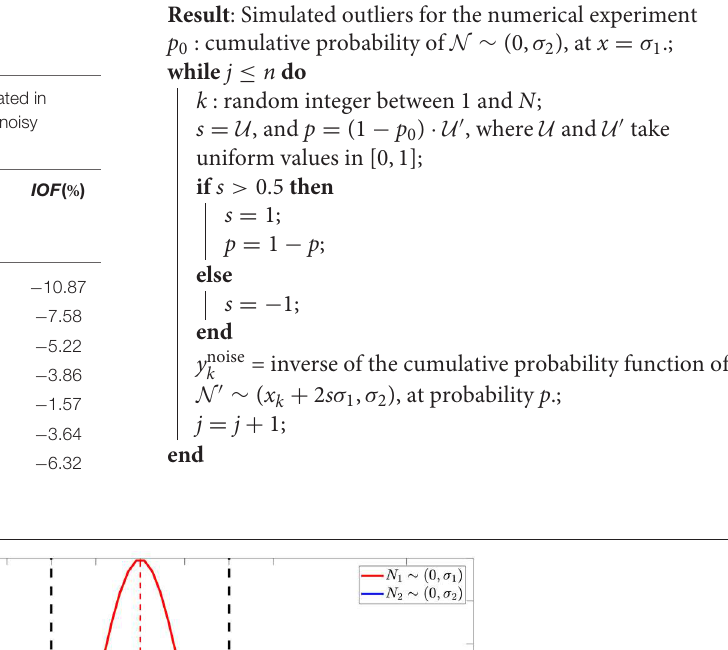
Algorithm 2: Numerical experiment with simulated outliers.